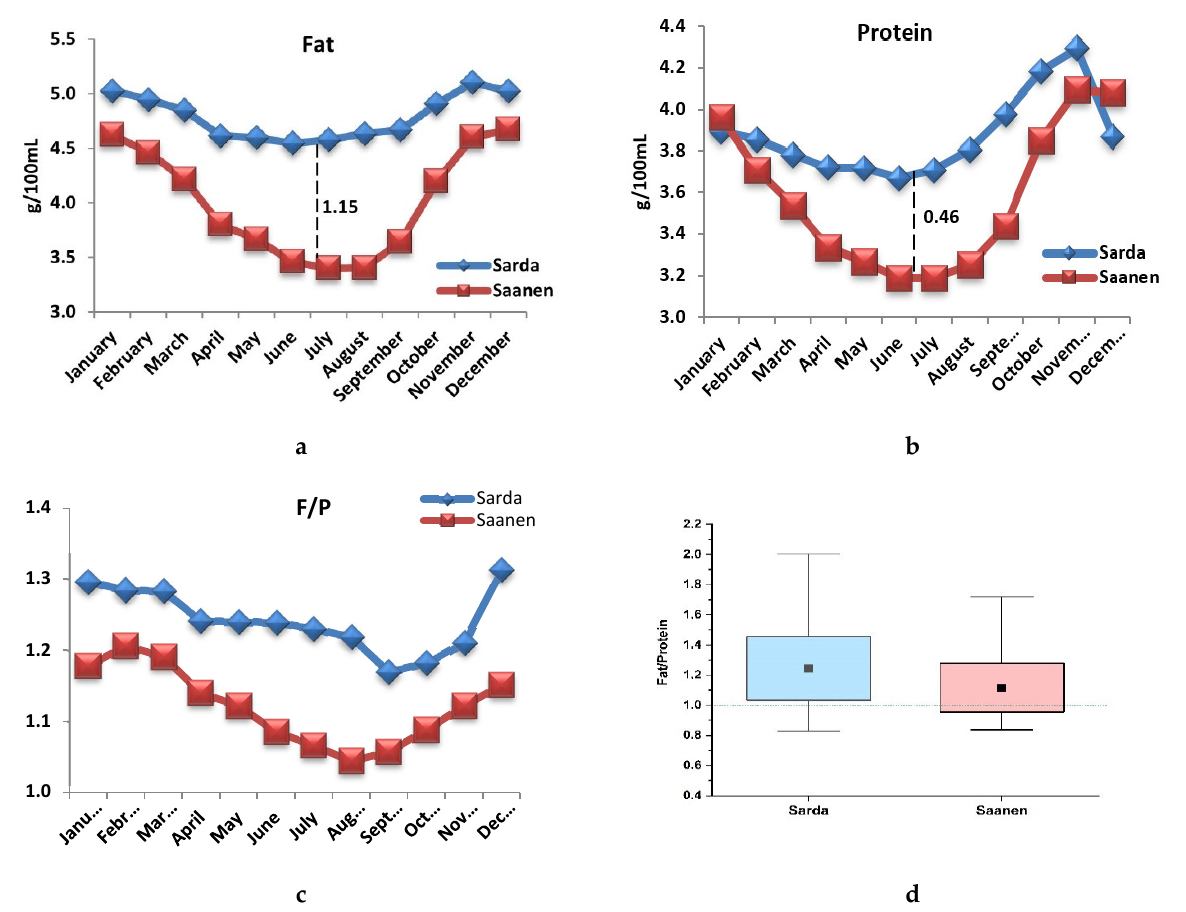
reported in Figure 2.